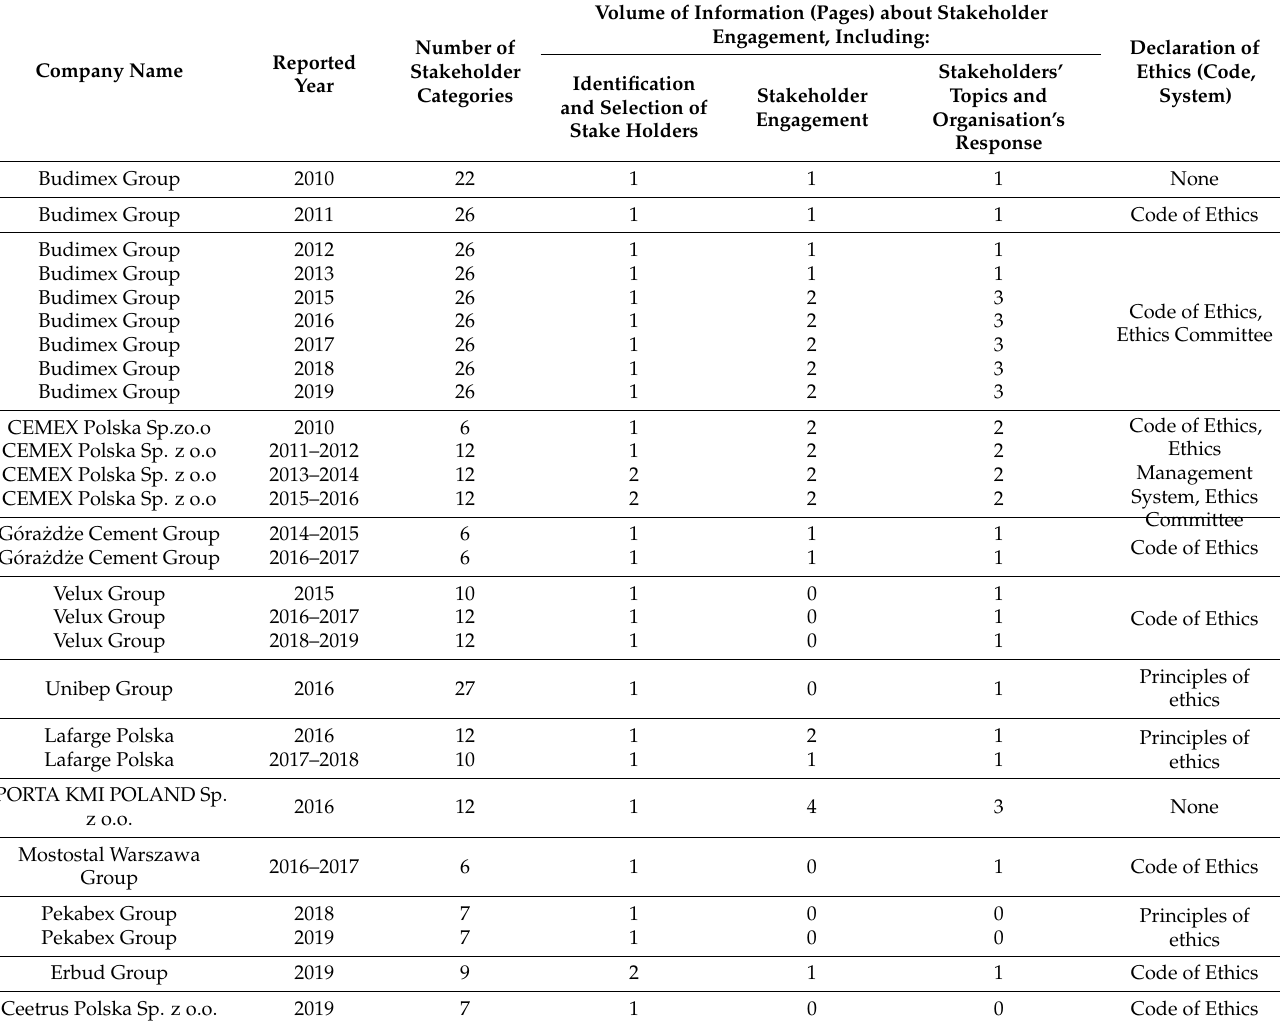
Table A2. Disclosures on stakeholder approaches and declaration of